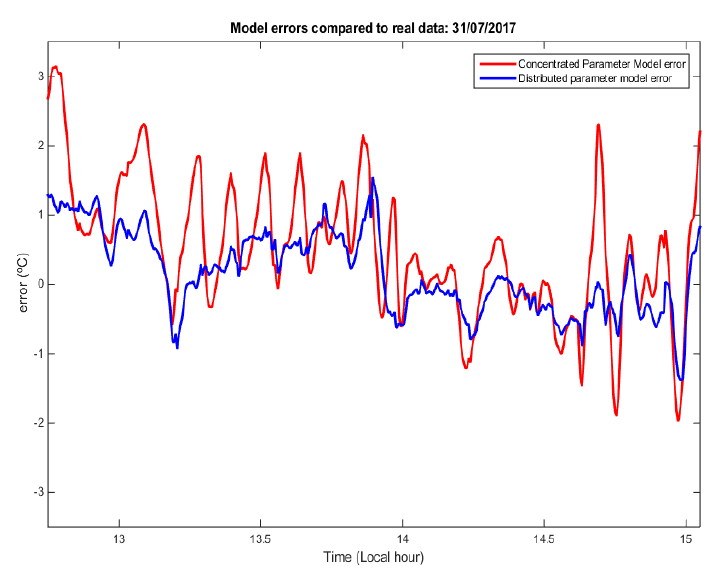
Figure 7. Comparison between distributed (blue) and concentrated parameter (red) models: evolution of the error between the models and real outlet temperature